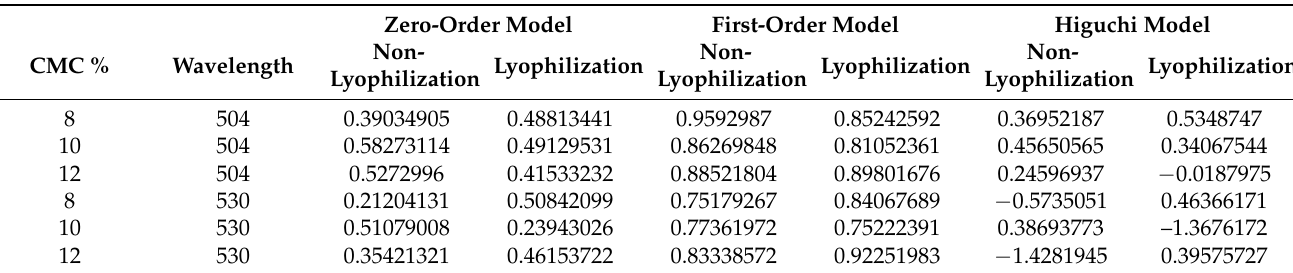
Table 1. R-square value results of release model